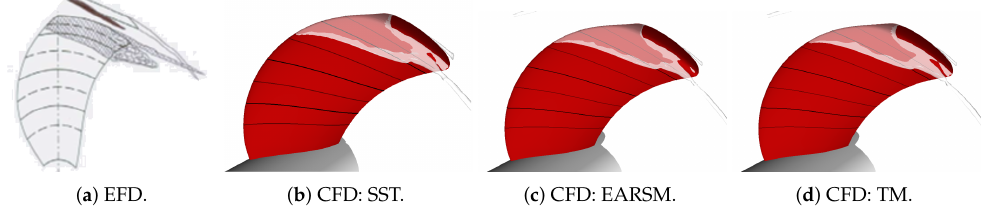
Figure 10. Comparison of near-blade cavitation patterns for the TLP.